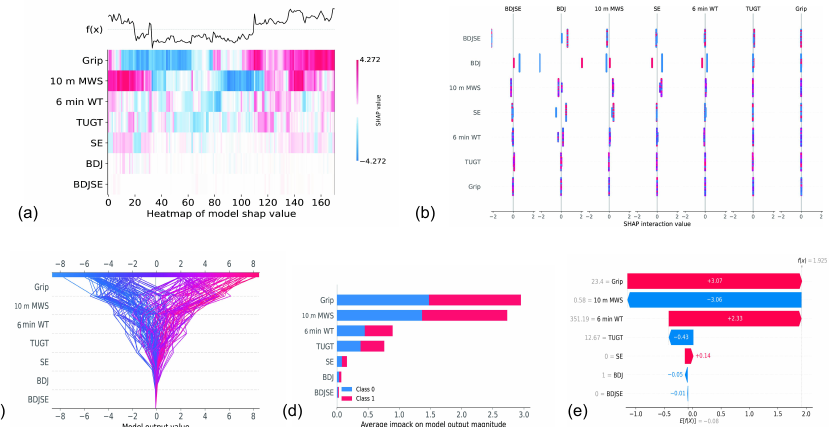
Figure 4. A plot that provides an overview of the SHAP values for every feature. The various characteristics are denoted along the y -axis. ( a ) illustrates the heat map of the various characteristic SHAP values, in which the x -axis depicts the series of the sample, red denotes a positive effect, blue denotes a negative effect, and the darker the color, the greater the extent to which it has an effect. The output is denoted by the function f ( x ) (before activation function). It is shown in the figure that the greatest essential characteristic shows a positive impact if the output also appears positive, and it demonstrates a clear boundary (threshold) in the characteristics; ( b ) shows the interaction SHAP values for various characteristics; ( c ) provides an outline of the characteristics that are highly essential to the model and the manner in which the model learned the outcome of every characteristic for each sample, with the x -axis denoting the model predicted values; ( d ) demonstrates the mean absolute SHAP value of each characteristic, with the x -axis denoting the average SHAP value; ( e ) depicts characteristics that have a role in displaying the model result from the fundamental value of a specific sample, with the SHAP value denoted along the x -axis. According to the previous situation, the grip strength demonstrated the most positive effect for predicting the frailty state and the 10 m MWS demonstrated a negative effect for predicting the frailty